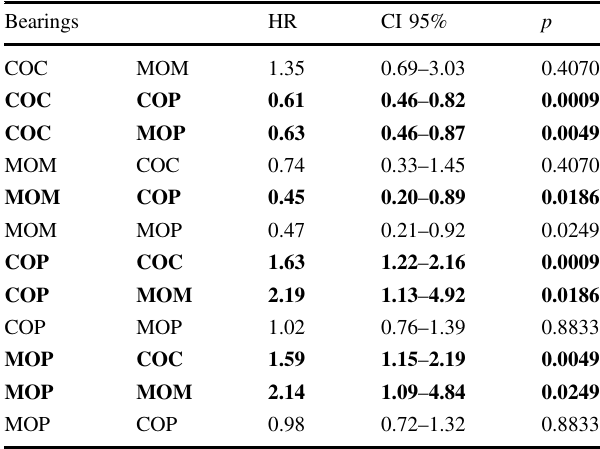
Table 4 Cox regression model investigating the in fl uence of bearings on revisions for dislocation was adjusted for age, gender, and head diameter (36 mm): in bold, signi fi cant fi ndings Bearings